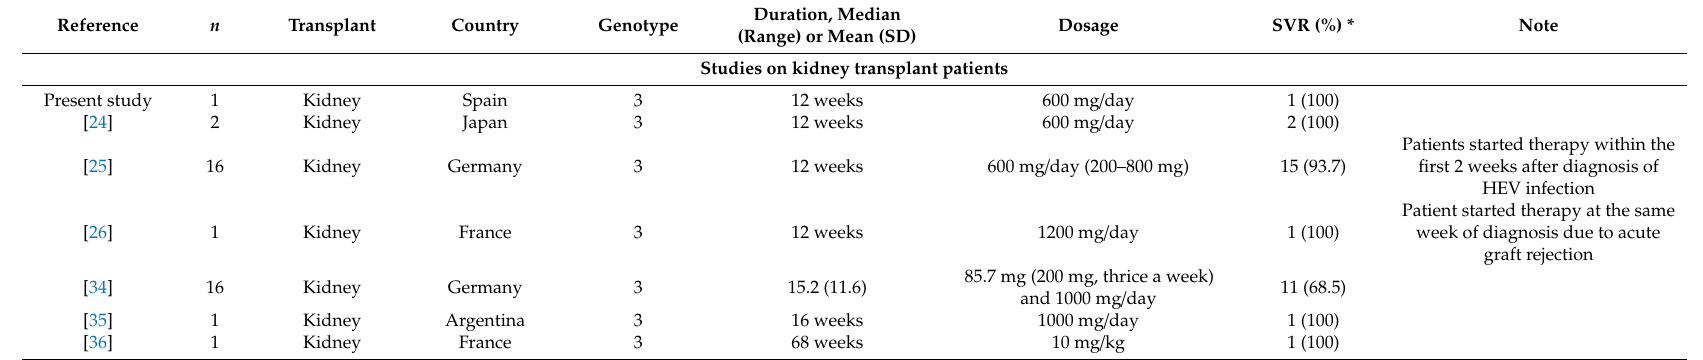
Table 2. E ffi cacy of ribavirin monotherapy as first treatment for hepatitis E virus genotype 3 infection in adult transplant recipient